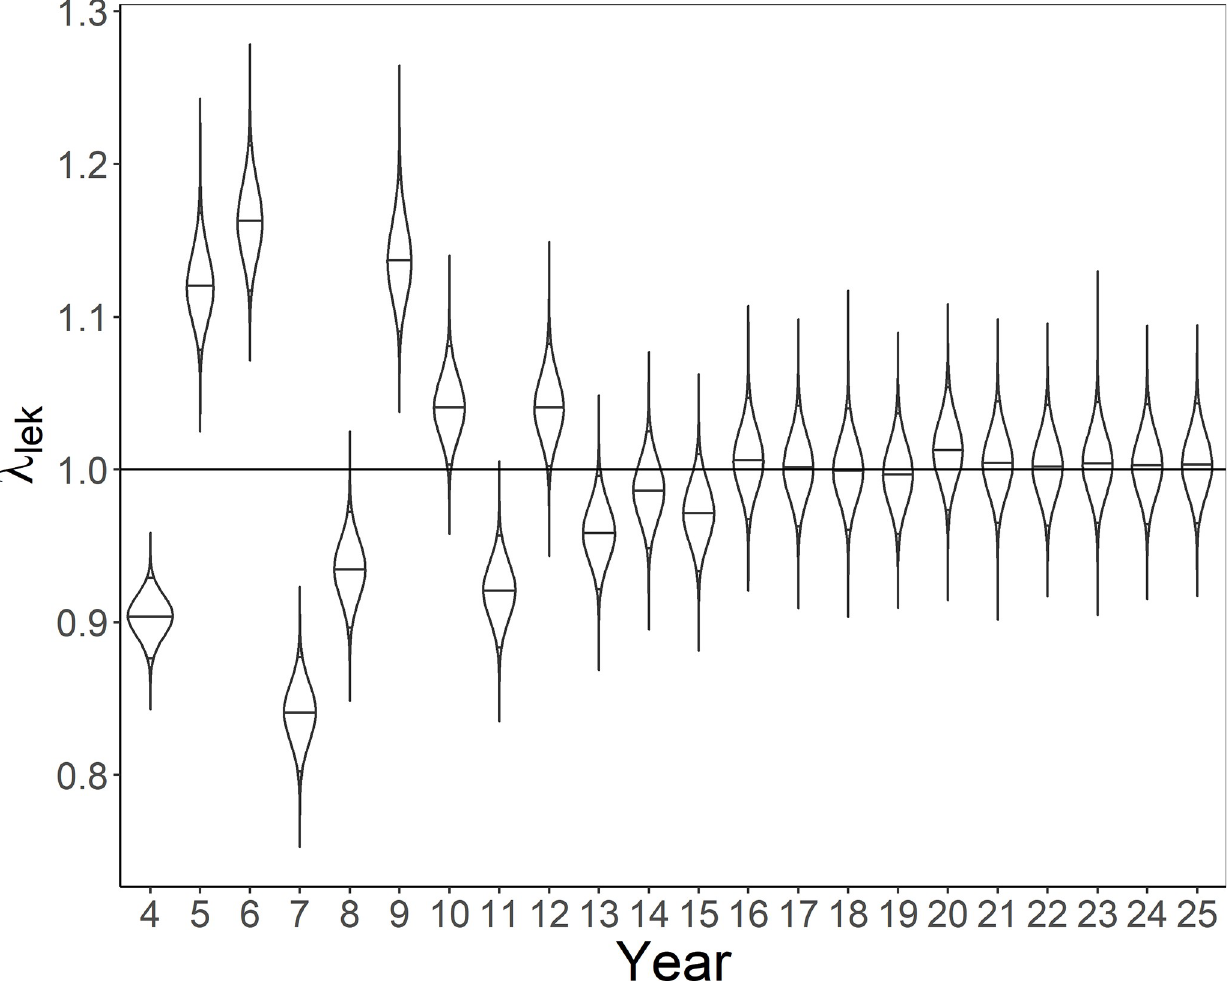
Fig 5. Violin plot of annual population growth rate of lesser prairie-chickens. Simulated data assuming temporally-varying detection probability (Scenario 9) from 100 simulations were estimated without an N-mixture model.